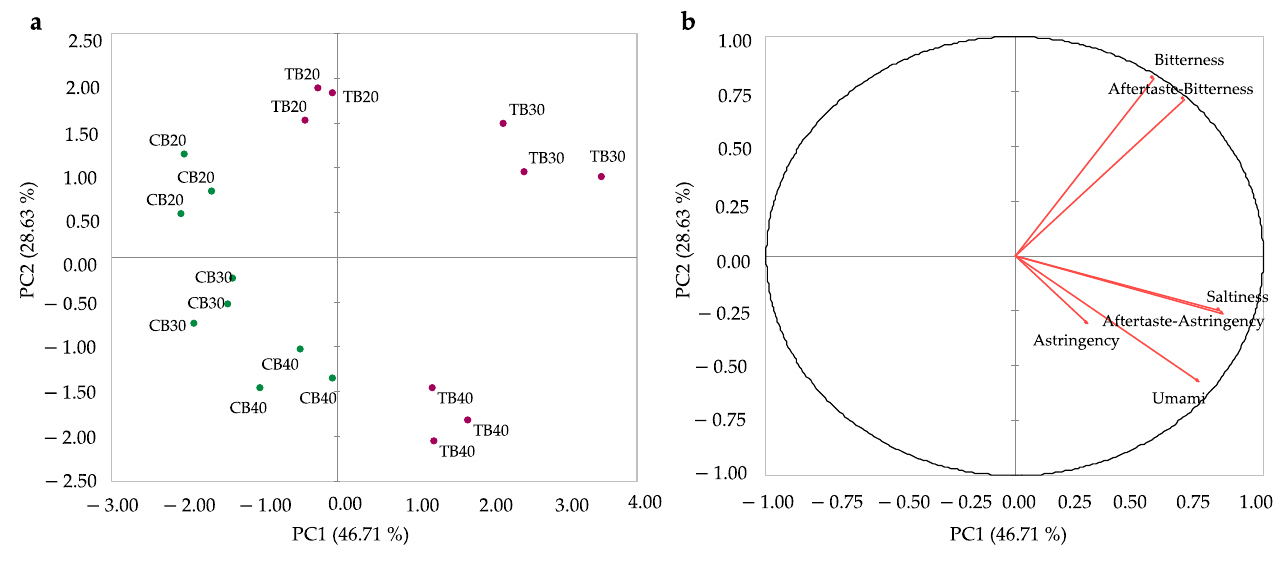
Figure 2. PCA score plot ( a ) and PCA loading plot ( b ) of e-tongue data collected on polenta enriched in common (CB) and Tartary (TB) buckwheat flour at various ratios (20%: CB20, TB20; 30%: CB30, TB30; 40%: CB40, TB40). Table 1. Color attributes of polenta prepared from corn meal enriched in common (CB) and Tartary (TB) buckwheat flour at various